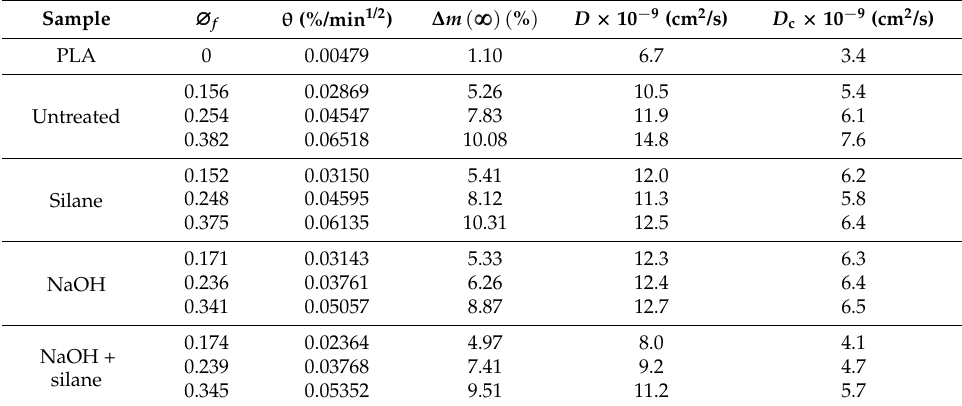
Table 1. Fiber volume fraction ( ∅ f ), initial linear slope ( θ ), equilibrium water uptake ( ∆ m p8q ), diffusion coefficient ( D ) and corrected diffusion coefficient ( D c ) values for poly(lactic acid) matrix and